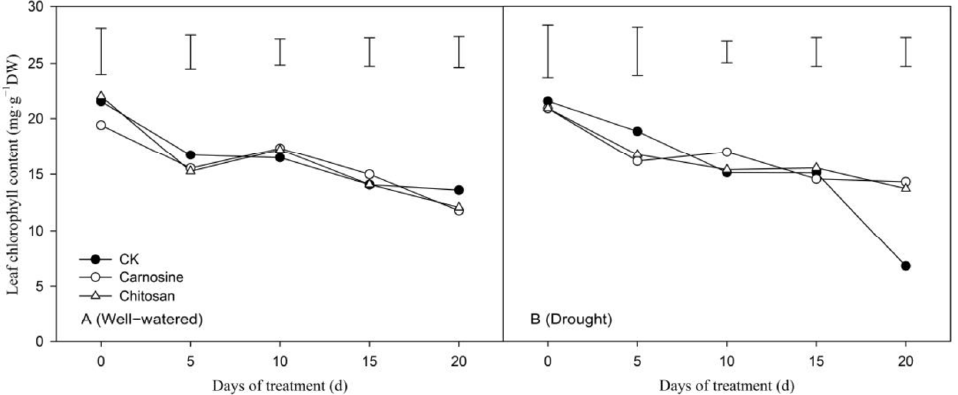
Figure 5. Effects of different concentrations of carnosine and chitosan on leaf chlorophyll content under drought stress in bermudagrass. ‘CK’ represents control plants sprayed with distilled water under both well-watered and drought stress. Vertical bars represent LSD values where a significant difference ( p < 0.05) was detected among different treatments at the same time point.